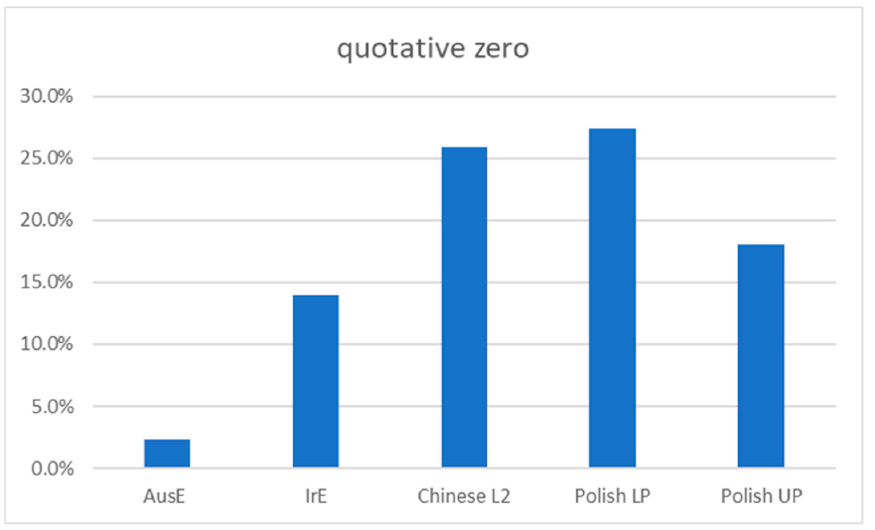
Figure 2. Frequency of quotative zero among two NS (AusE and IrE) and three L2 (Chinese L2, Polish Lower and Upper Proficiency) groups.